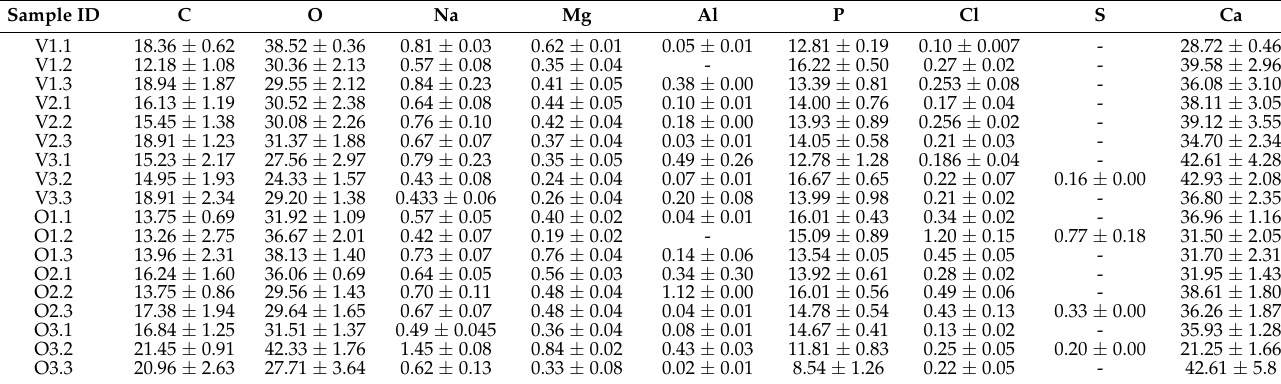
Table 2. Calcium mass percentages reported with EDX with their respective standard deviations.